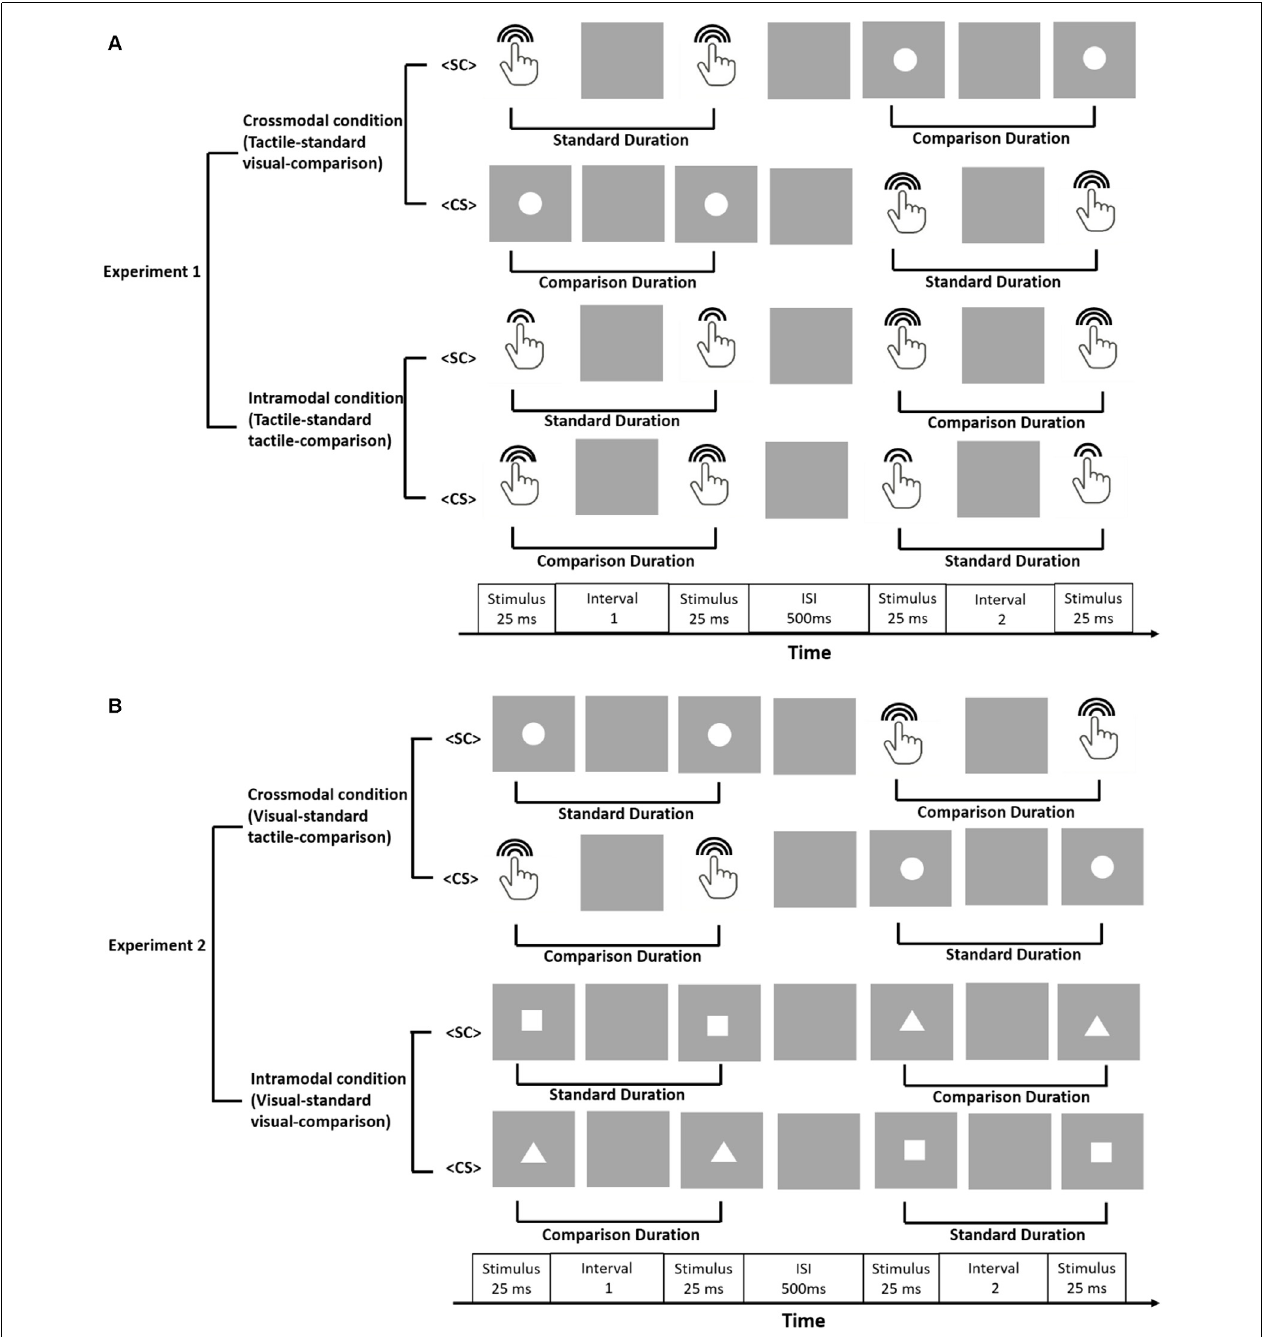
FIGURE 1 | Experimental paradigm. Panel (A) illustrates the setup for Experiment 1. The crossmodal condition of Experiment 1 was set as tactile-standard visual-comparison while the intramodal condition was set as tactile-standard tactile-comparison. Panel (B) illustrates the setup for Experiment 2. The crossmodal condition of Experiment 2 was set as visual-standard tactile-comparison while the intramodal condition was set as visual-standard